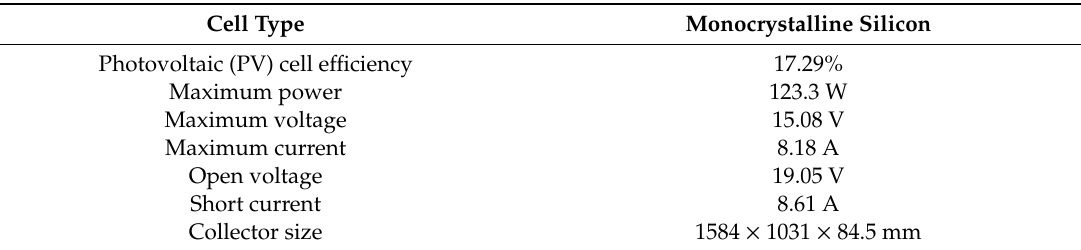
Table 1. PVT module